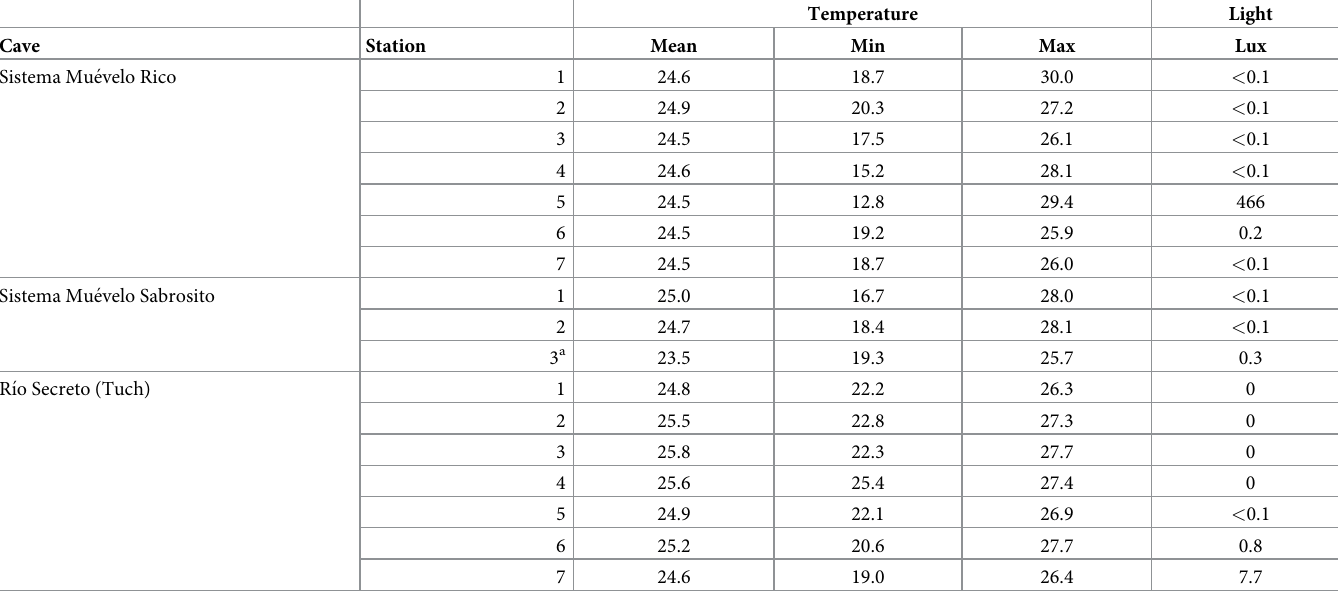
Table 1. Basic temperature (˚C), and light intensities (lux) for the 17 monitoring stations.